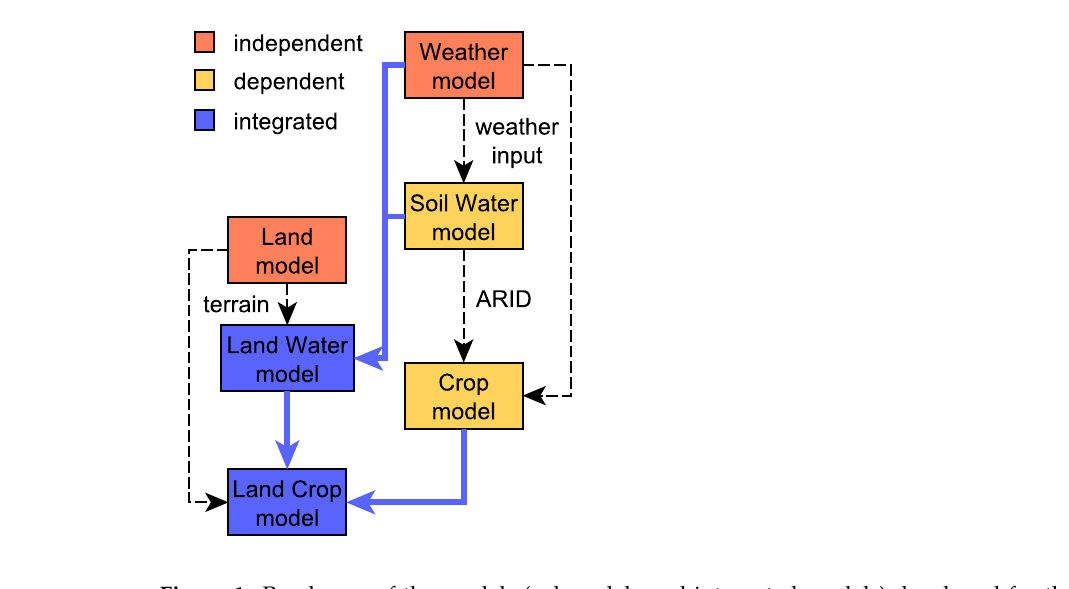
Figure 1. Road map of the models (submodels and integrated models) developed for the Indus Village model covered in this